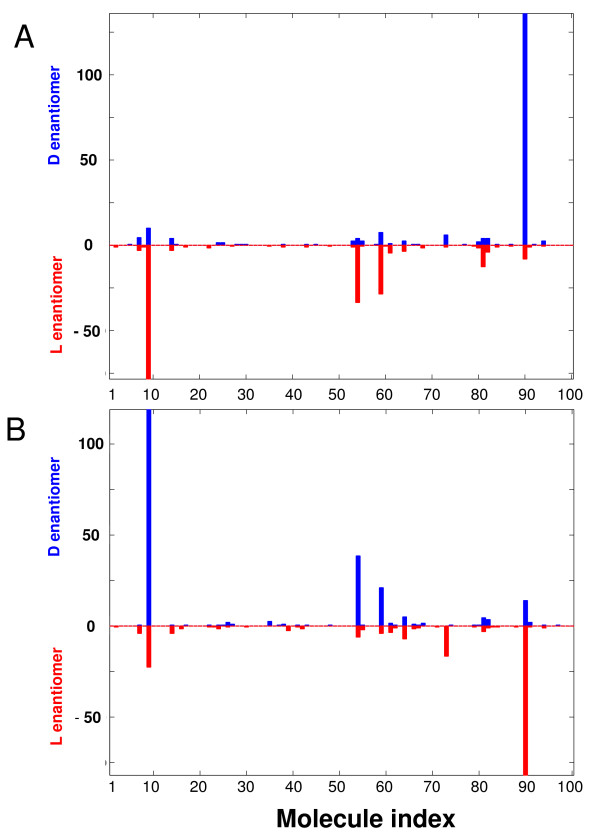
Compositional bar-chart for the composomes C2 and C3 (Figure 7). The molecule index is serial number representation of the different compounds (1...NG), and D and L enantiomers are indicated by color and vertical direction. The Y axis is the count of a given molecule type within the composomal assembly.